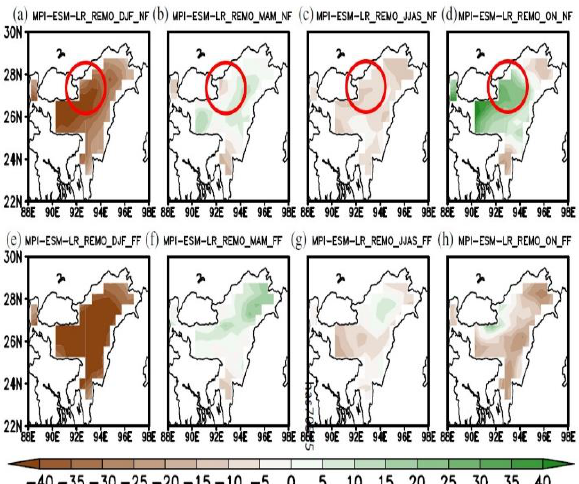
Figure 7 . Change in precipitation